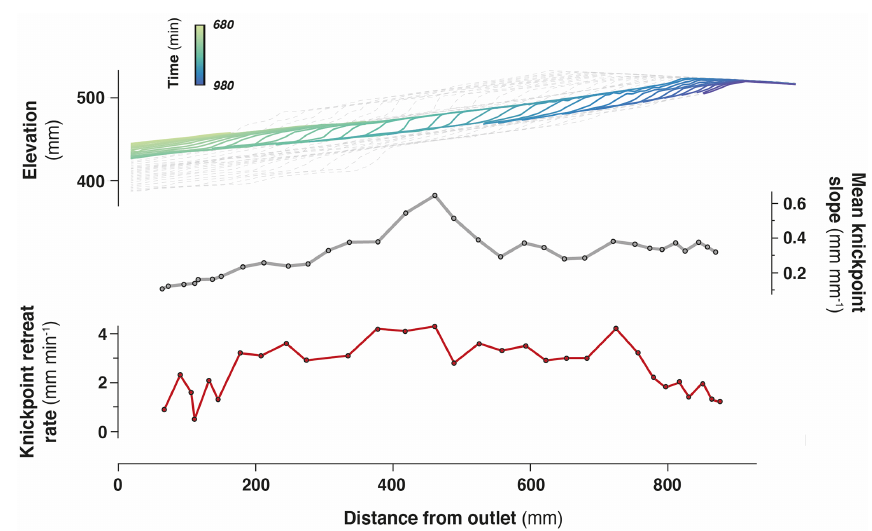
Figure 7. Retreat of an individual knickpoint from experiment BL10 (see also Fig. 6) showing its initiation with a gentle slope which subsequently steepens as it migrates upstream (see also Fig. S3). Its maximum slope is reached at mid-distance between the outlet and the divide. Its lowest retreat rates are observed downstream near the outlet and upstream near the